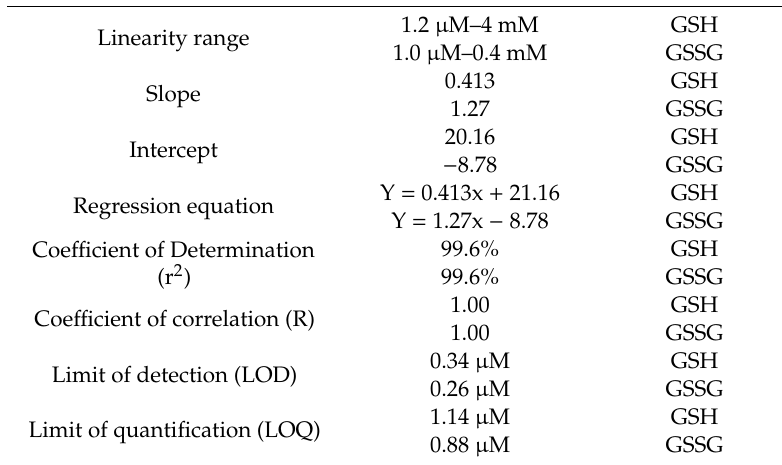
Table 1. Linearity and prediction power of the glutathione method. X and Y are the glutathione concentration and detector signal, respectively (GSSG: p < 0.001).